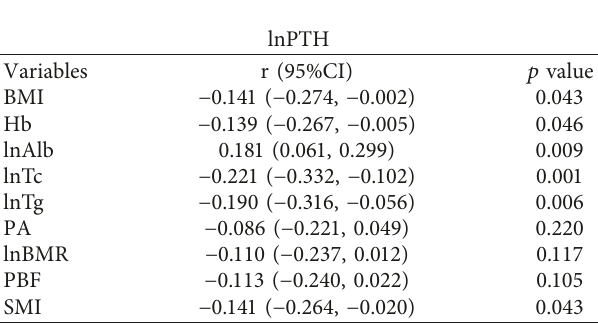
Figure 1: Percentage of low SMI at different CKD stage groups. ( p value � 0.037).